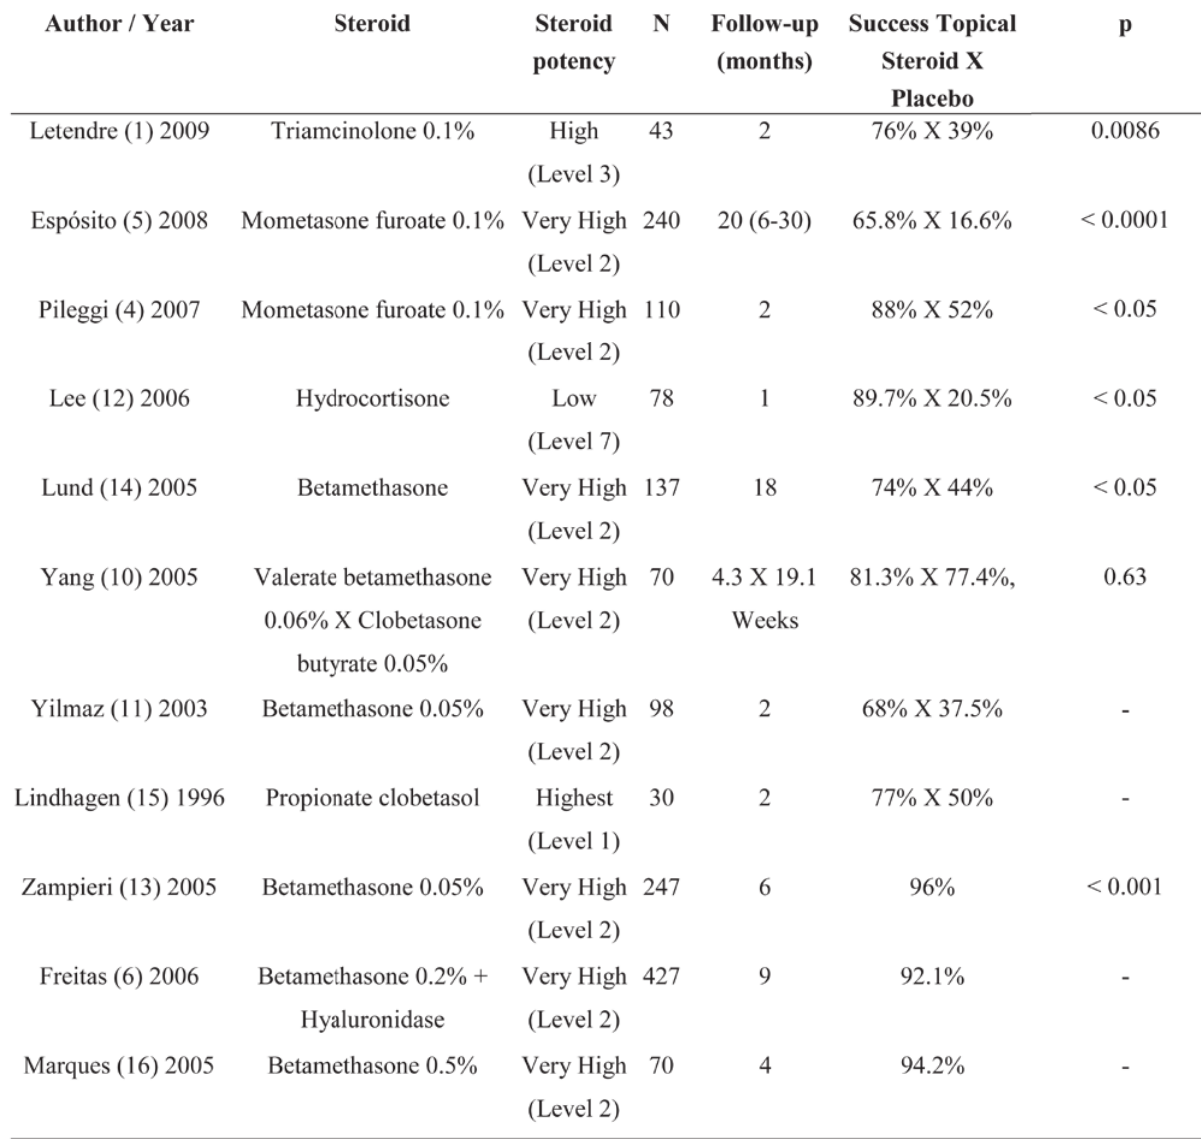
Topical betamethasone in the treatment of